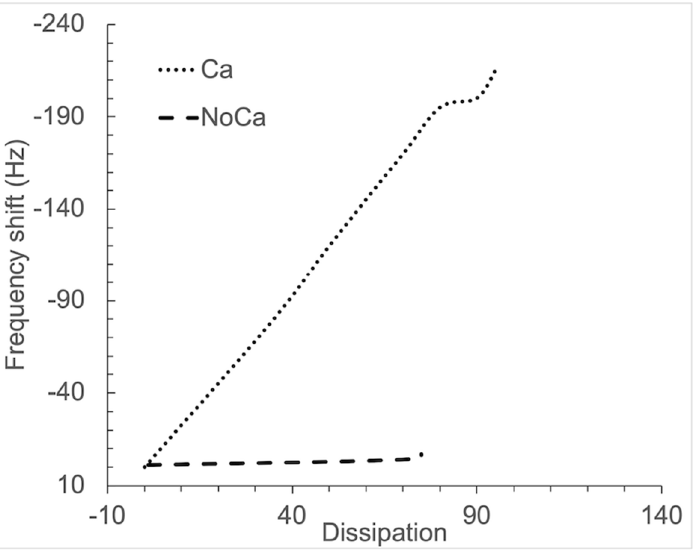
Figure 3. Representative f/ D plots of the surfaces. The frequency shift ( f ) is given on the Y-axis, and registration starts for all surfaces when Ca 2+ is added ( f = 0). The corresponding dissipation values are given on the X-axis. The experimental time span is 45 min.